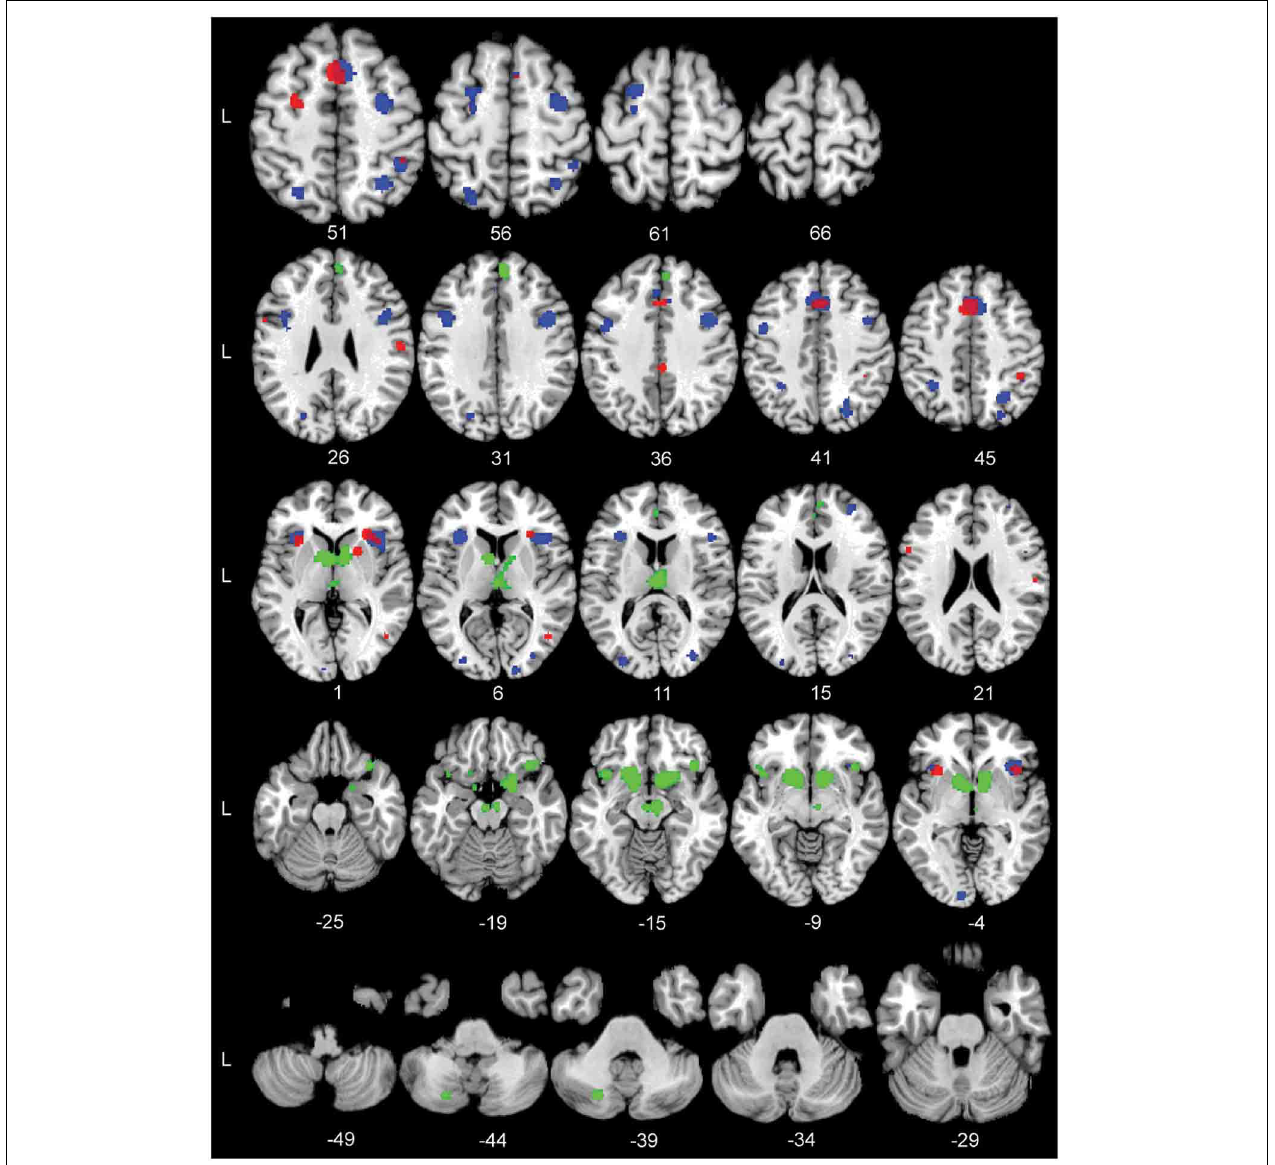
FIGURE 2 | The significant Activation Likelihood Estimate (ALE) clusters for the three separate ALE analyses in standard Montreal Neurological Institute space. Red: Task > Control; blue: Hard > Easy; green: Reward > Control. Numbers indicate Z coordinates in MNI space.